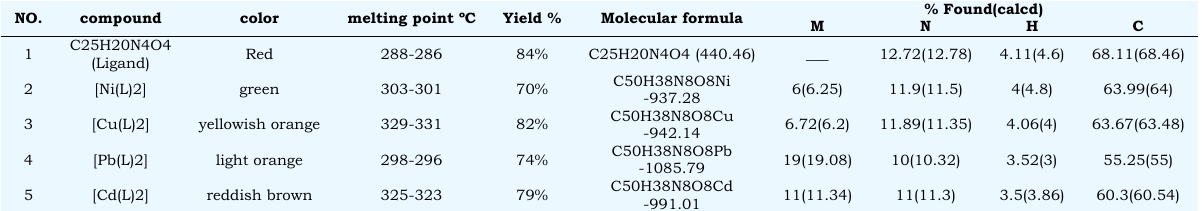
Table 1 C.H.N analytic data and physical properties of ligand as well its complexes